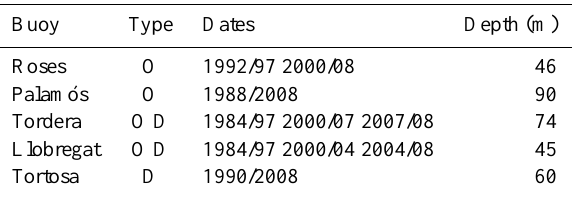
Table 1. Main characteristic of wave buoys (O: omnidirectional (scalar) buoy D: directional